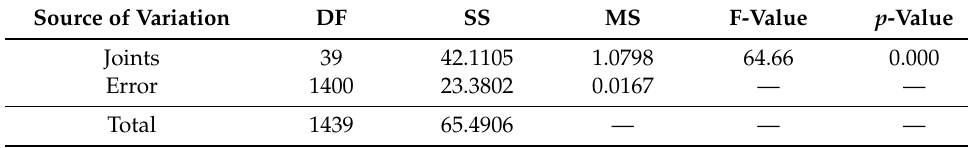
Table 4. The result of analysis of variance (ANOVA).